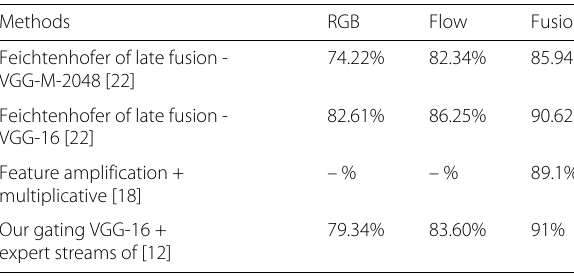
Table 12 Comparison with another fusion method Methods